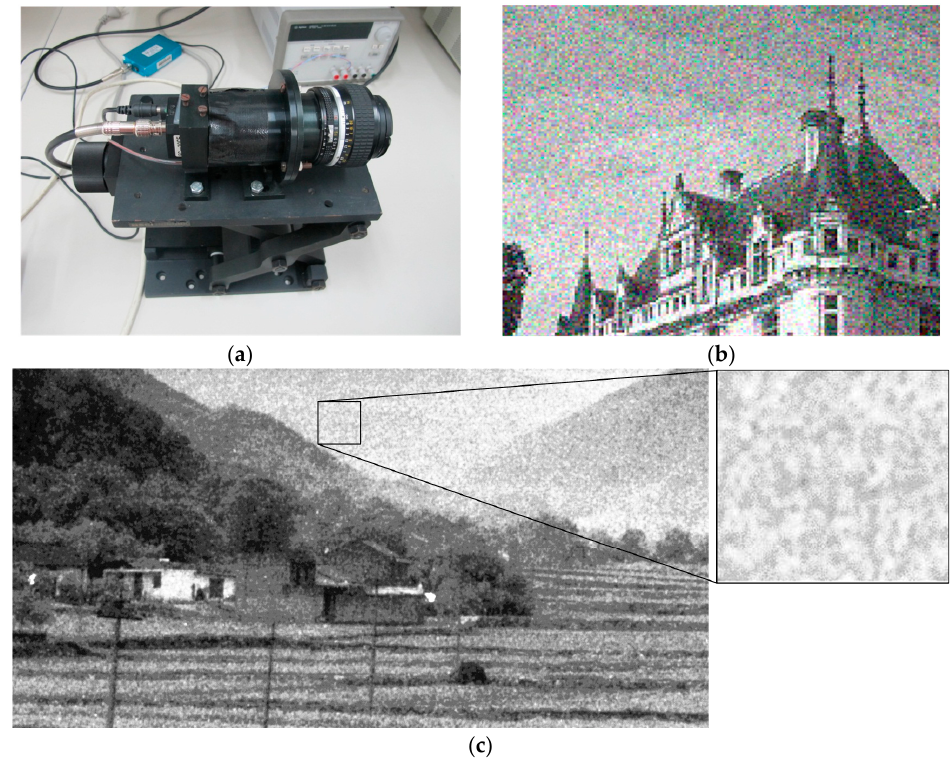
Figure 1. ( a ) The used ICCD device; ( b ) a natural image with white noise; ( c ) an image captured by ICCD image sensor (enhanced by histogram equalization) and its noise pattern.